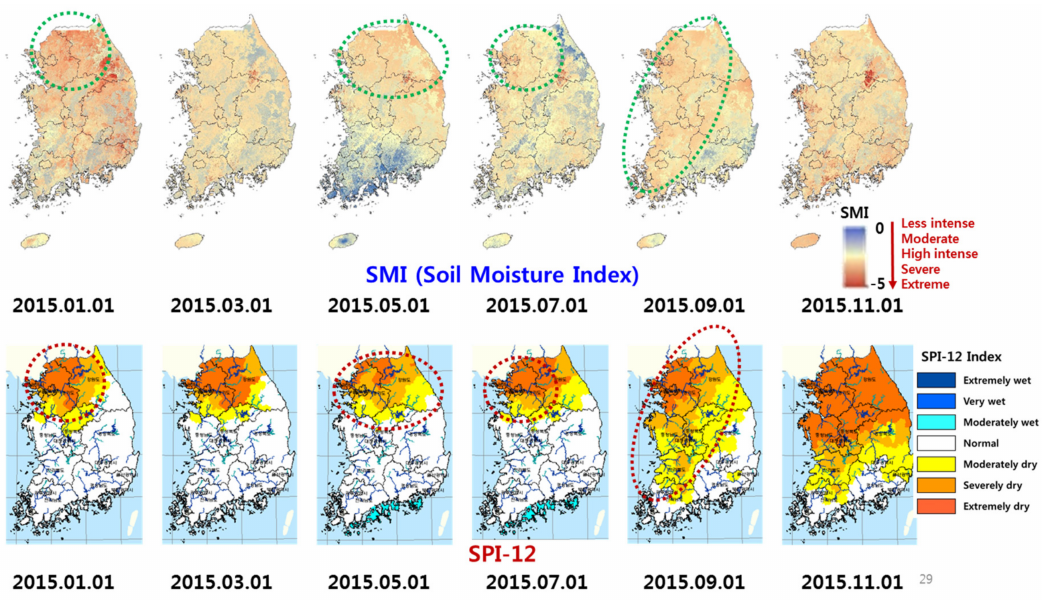
Figure 10. Comparison of the soil moisture index (SMI) and standardized precipitation index (SPI): green and red dashed circles indicate areas where the SMI and SPI exhibited good